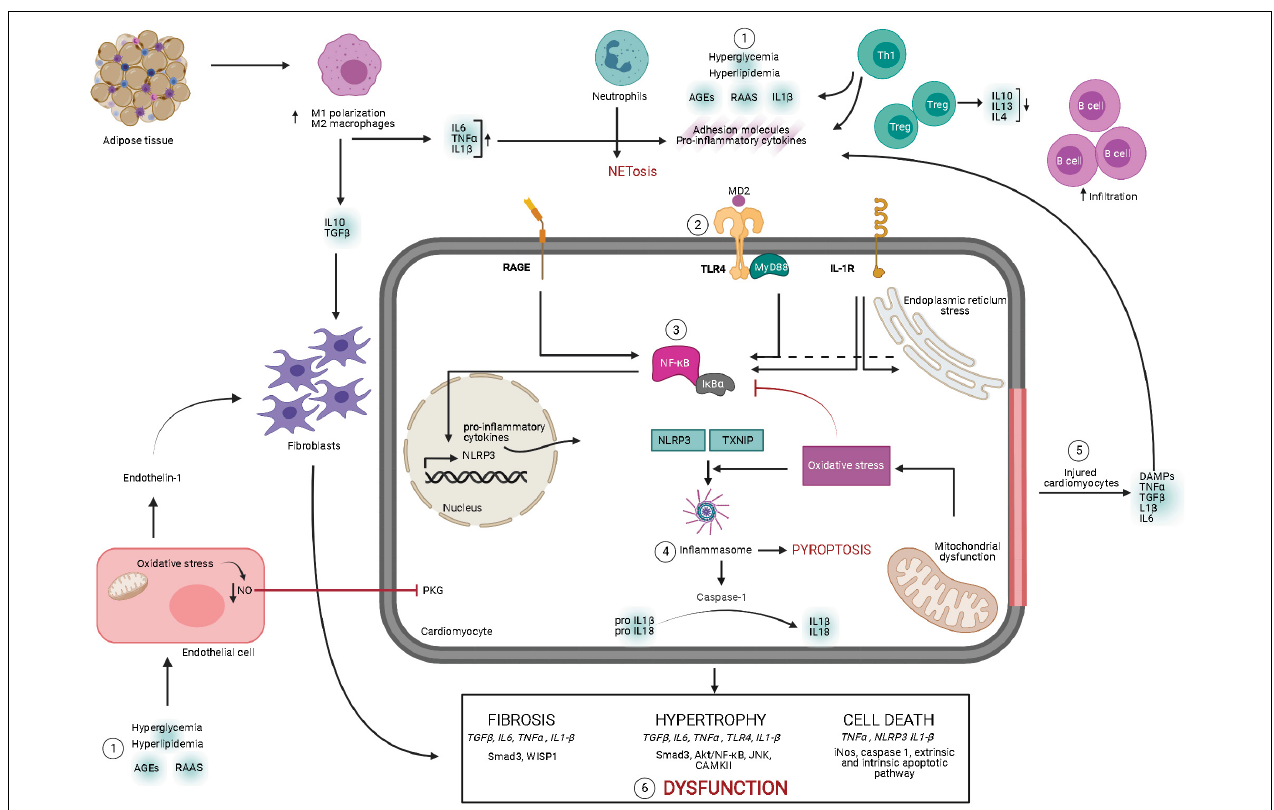
FIGURE 1 | Overview of signaling mechanisms underlying myocardial inflammation in diabetes mellitus. Diabetic milieu comprises of elevated leukocyte homing in the myocardium. Pathological stresses such as hyperglycemia, hyperlipidemia, elevated RAAS, and AGEs induce secretion of pro-inflammatory molecules, adhesion molecules, and DAMPs from the leukocytes. Moreover, these instigators also induce ROS-mediated endothelial dysfunction contributing to cardiac remodeling. Secreted pro-inflammatory cytokines bind to the receptors, such as TLR-4–MyD88 complex, RAGE, and IL-1R, and initiate their intracellular signaling pathways. These pathways activate NF- κ B, resulting in transcriptional upregulation of inflammatory cytokines and NLRP3 inflammasome. Following NF- κ B activation and oxidative stress, inflammasome assembly leads to maturation of IL-1 β and IL-18, along with induction of pyroptosis. Meanwhile, stressed or injured cardiomyocytes release pro-inflammatory cytokines and DAMPs, contributing to aggravated inflammatory cascades. Chronic inflammatory cytokine-induced intracellular response leads to pathological cardiac remodeling and cardiac dysfunction. AGE, advanced end glycation products; DAMP, danger-associated molecular pattern; IL, interleukin; IL-1R, interleukin 1 beta receptor; MD2, myeloid differentiation 2; MyD88, myeloid differentiation primary response 88; NLRP3, NLR family pyrin domain containing 3; NETosis, neutrophil-mediated cell death; NF- κ B, nuclear factor kappa-light-chain-enhancer of activated B cells; NO, nitric oxide; PKG, protein kinase G; RAAS, renin–angiotensin–aldosterone system; RAGE, receptor for AGEs; TGF β , transforming growth factor beta; TLR-4, Toll-like receptor 4; TNF α , tumor necrosis factor alpha; TXNIP, thioredoxin-interacting/inhibiting protein (created with